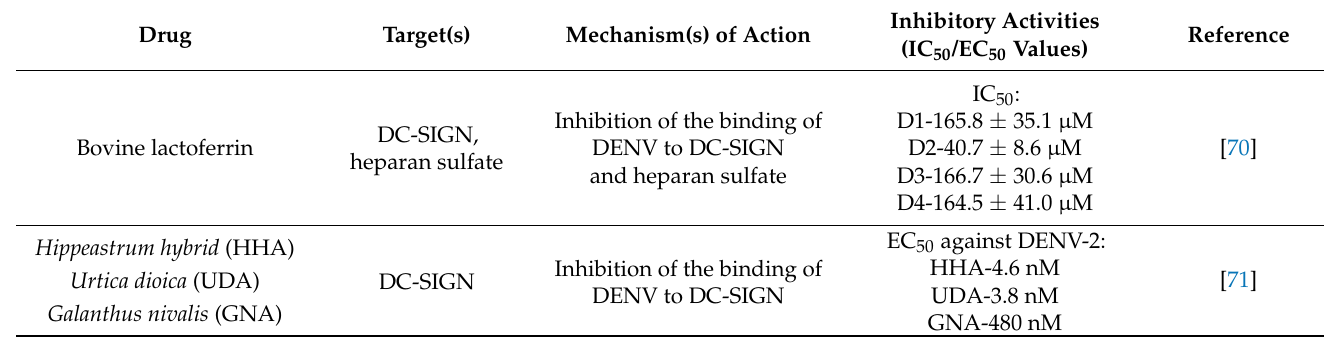
Table 2. Host-directed antivirals of